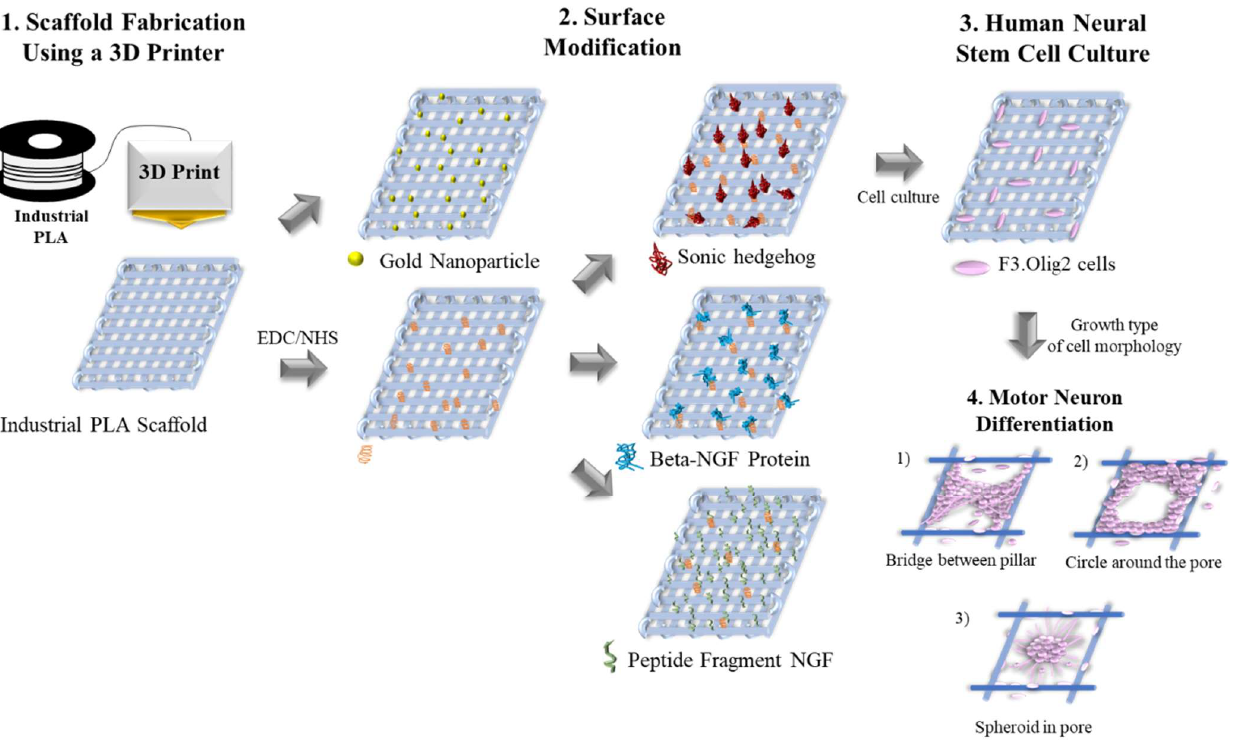
Figure 1. Schematic diagram showing surface modifications of the industrial polylactic acid (PLA) three-dimensional scaffold (IPTS) for motor neuron differentiation.